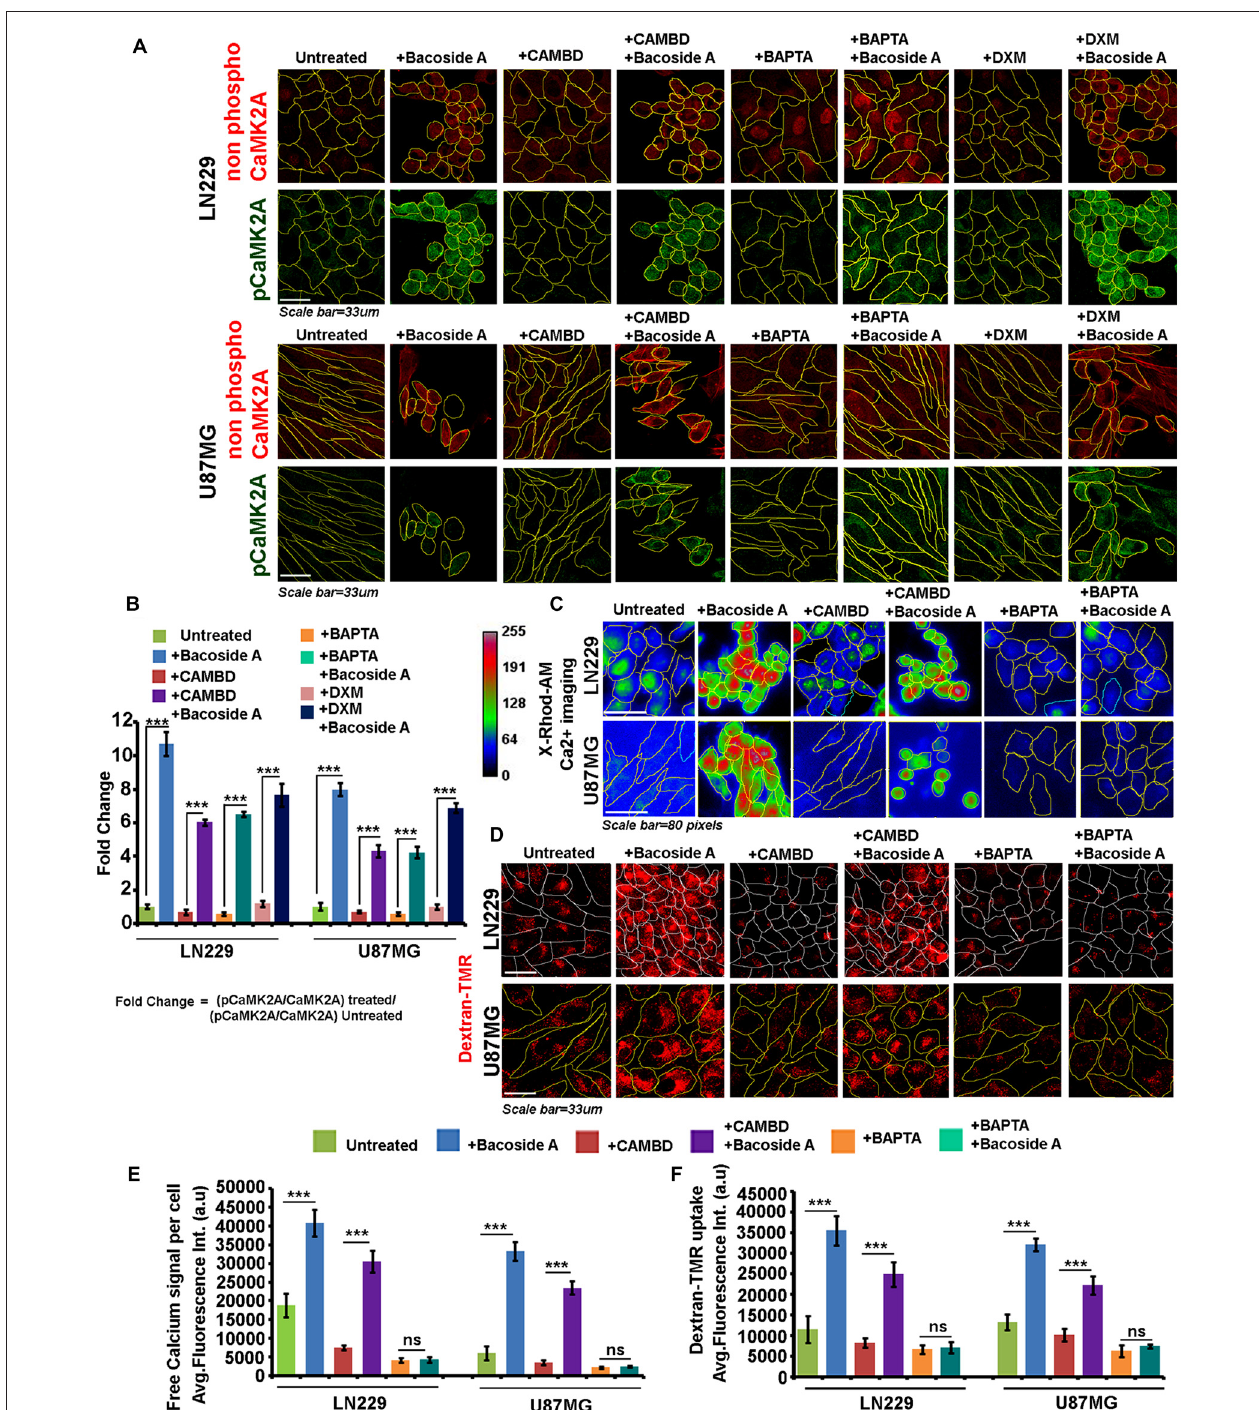
FIGURE 10 | Bacoside A uncontrolled macropinocytotic effects are dependent on phospho-CAMK2A mediated intracellular calcium upsurge. (A) Single cell quantitative image analysis procedure (see John et al., 2017) was employed to measure non-phospho CaMK2A and pCaMK2A-T286 protein levels in various GBM patient derived tumor cell lines: U87MG and LN229 upon Bacoside A (8 µ g/ml) and inhibitor treatments for 24 h. (A,B) The proportion of phosphorylated CaMK2A was determined by normalizing average signal from pCaMK2A-T286 to average signal from non-phospho CaMK2A in treated cells. Results showed higher levels of pCaMK2A in Bacoside A treated tumor cells vs. the untreated control cell lines. Please note that just “CaMK2A” in the formula refers to predominantly the non-phosphorylated pool. Similar results were obtained even in presence of CAMBD (competitive inhibitor of CaMK2A phosphorylation),